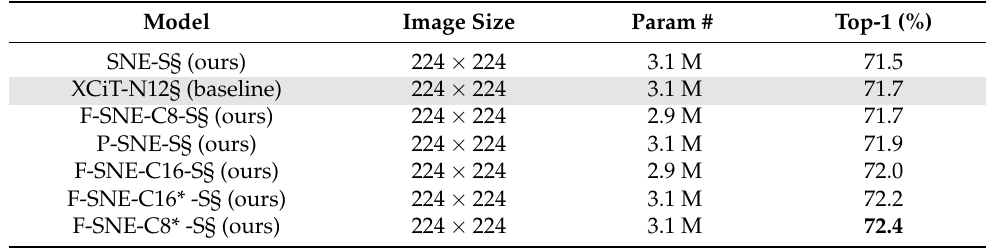
Table 5. Proposed models were evaluated on ImageNet classification with distillation. XCiT perfor- mance was obtained from [9]. § indicates the distilled